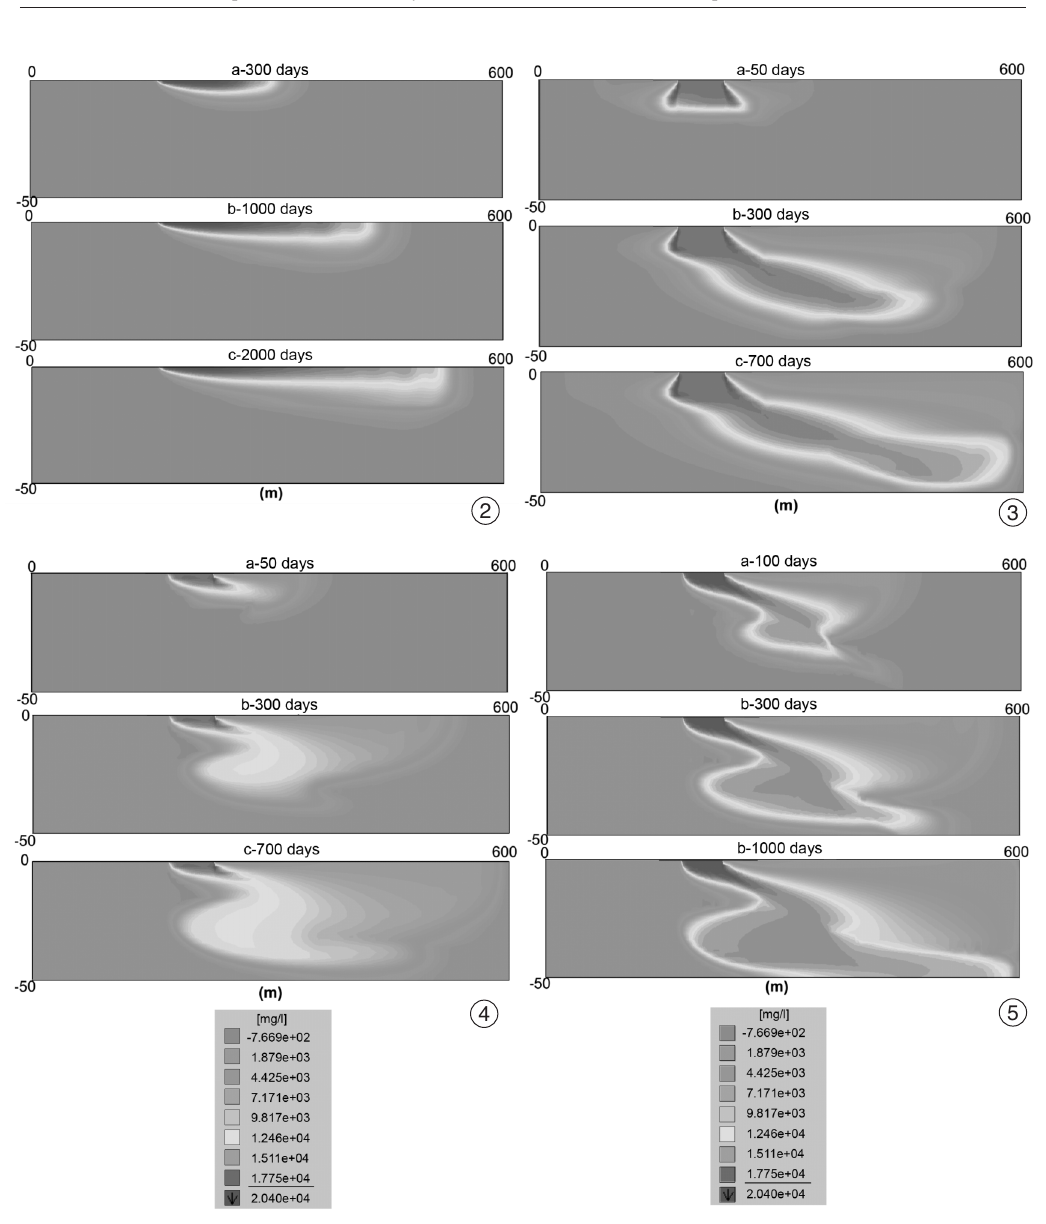
Fig. 2. Evolution in space and time of the solute transport, in terms of concentration, Model 1. Fig. 3. Evolution in space and time of the solute transport, in terms of concentration, Model 2, Scenario 1. Fig. 4. Evolution in space and time of the solute transport, in terms of concentration, Model 2, Scenario 2. Fig. 5. Evolution in space and time of the solute transport, in terms of concentration, Model